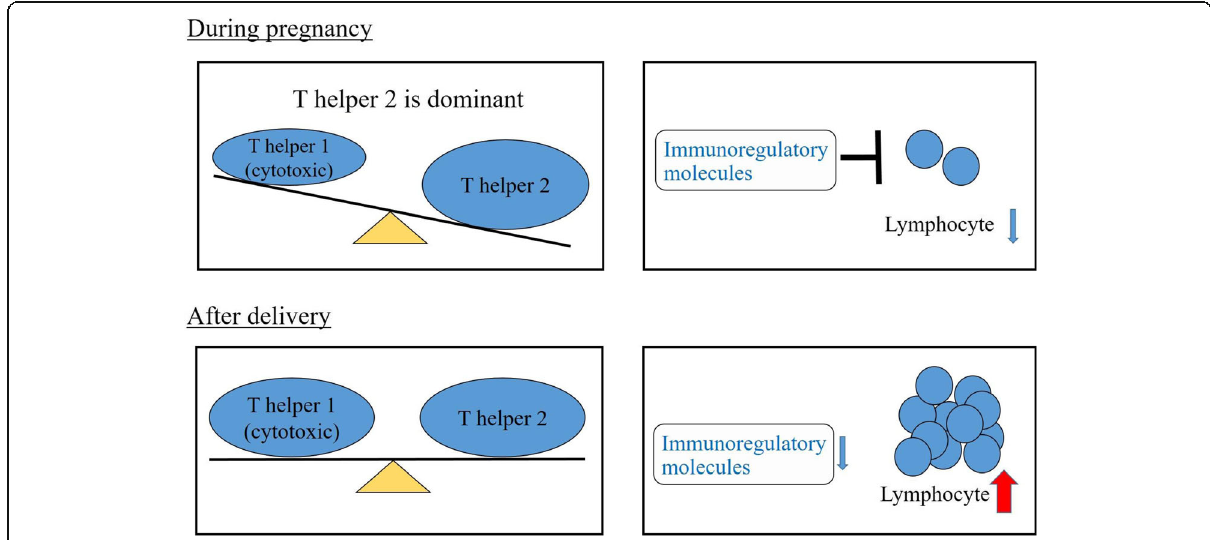
Fig. 3 The immune system during pregnancy and after delivery. The T helper 1-type reaction is downregulated during pregnancy. Moreover, immunoregulatory molecules, including progesterone-induced blocking factor (PIBF), placental suppressor factor and trophoblast cell-derived factor, suppress lymphocyte proliferation during pregnancy. After pregnancy, the T helper 2 dominance disappears. In addition, some or all of these immunoregulatory molecules are reduced and lymphocytes can proliferate after